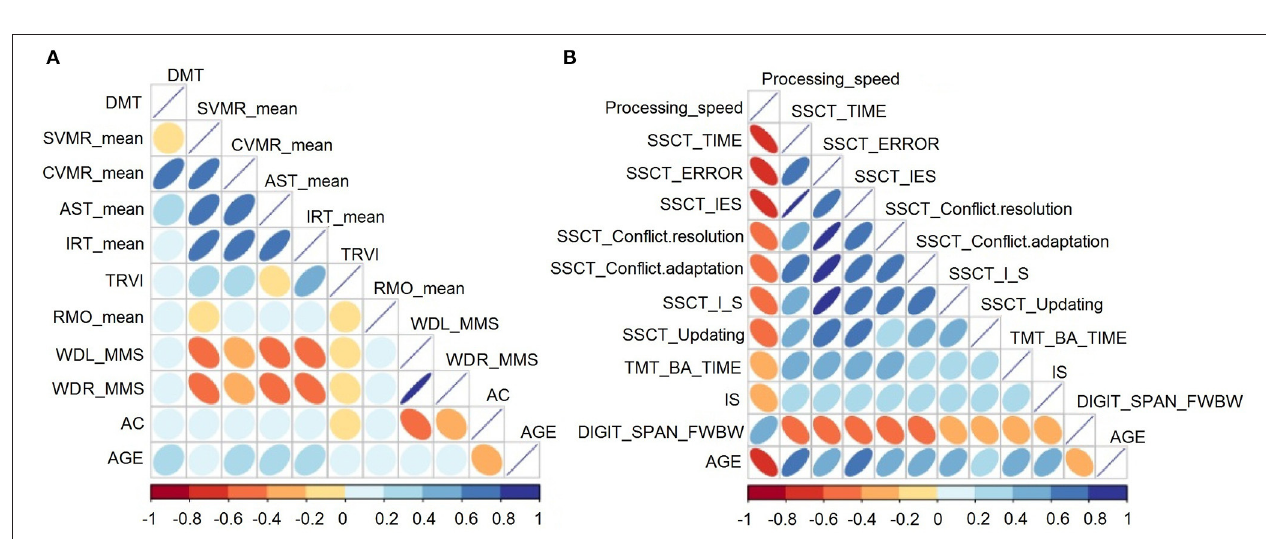
FIGURE 2 | Correlation matrix heatmap for the (A) psychophysiological outcomes of brain atrophy and (B) stroop switching card test datasets.